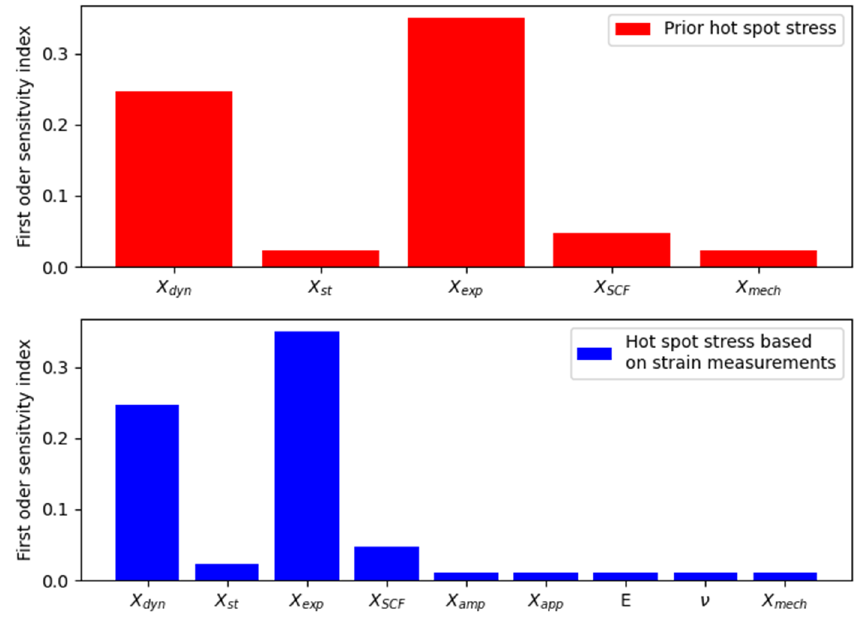
Figure 11. Sensitivity indexes for the random variables influencing the hot spot stress (prior and based on strain measurements).